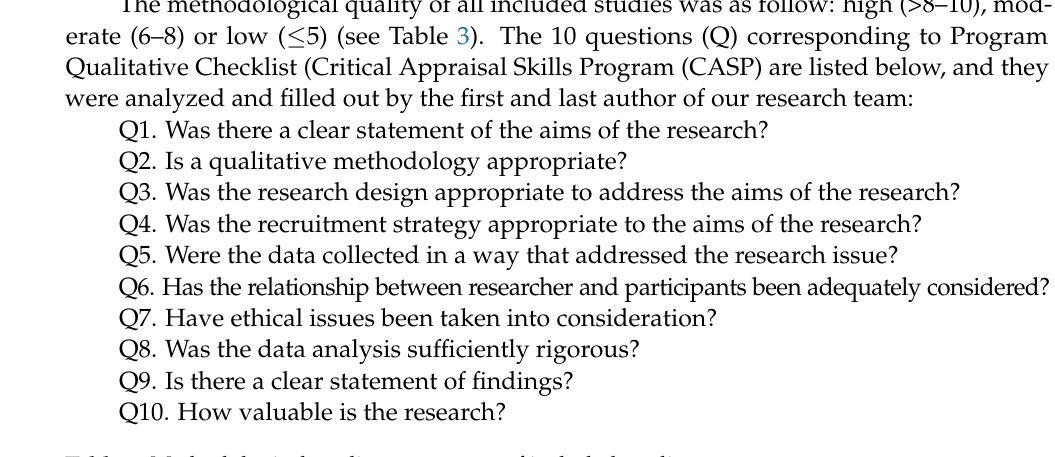
Table 3. Methodological quality assessment of included